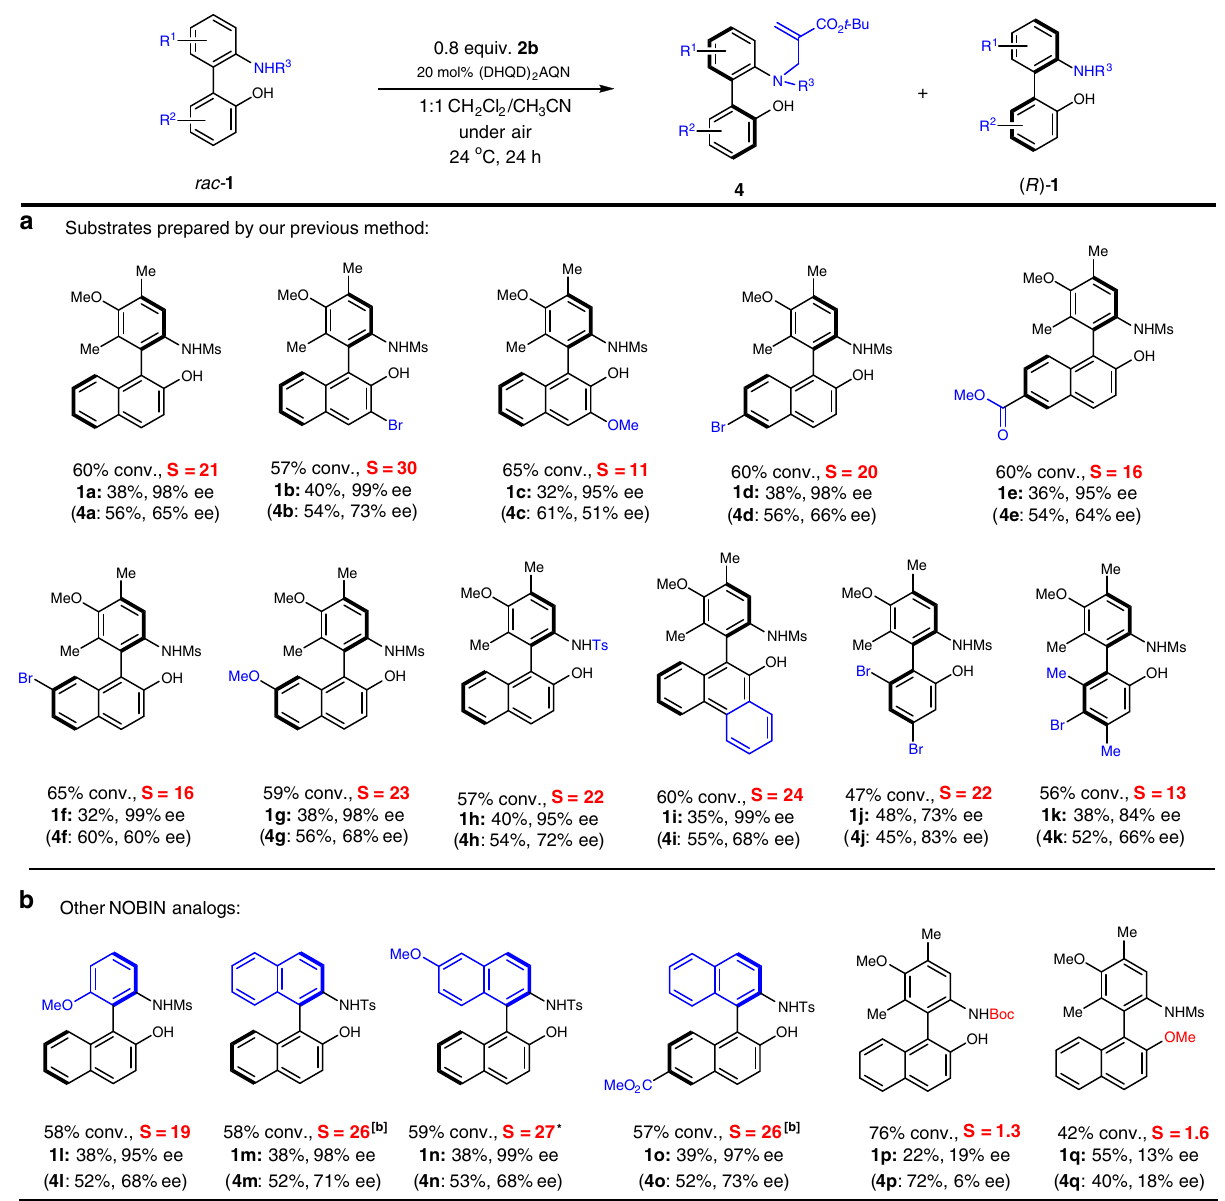
Fig. 2 Scope and structural exploration of NOBINs from kinetic resolution. a Substrates from one-step biaryl sulfonamide phenol synthesis. b More diverse biaryl amino phenols. * 0 ℃ reaction for 48